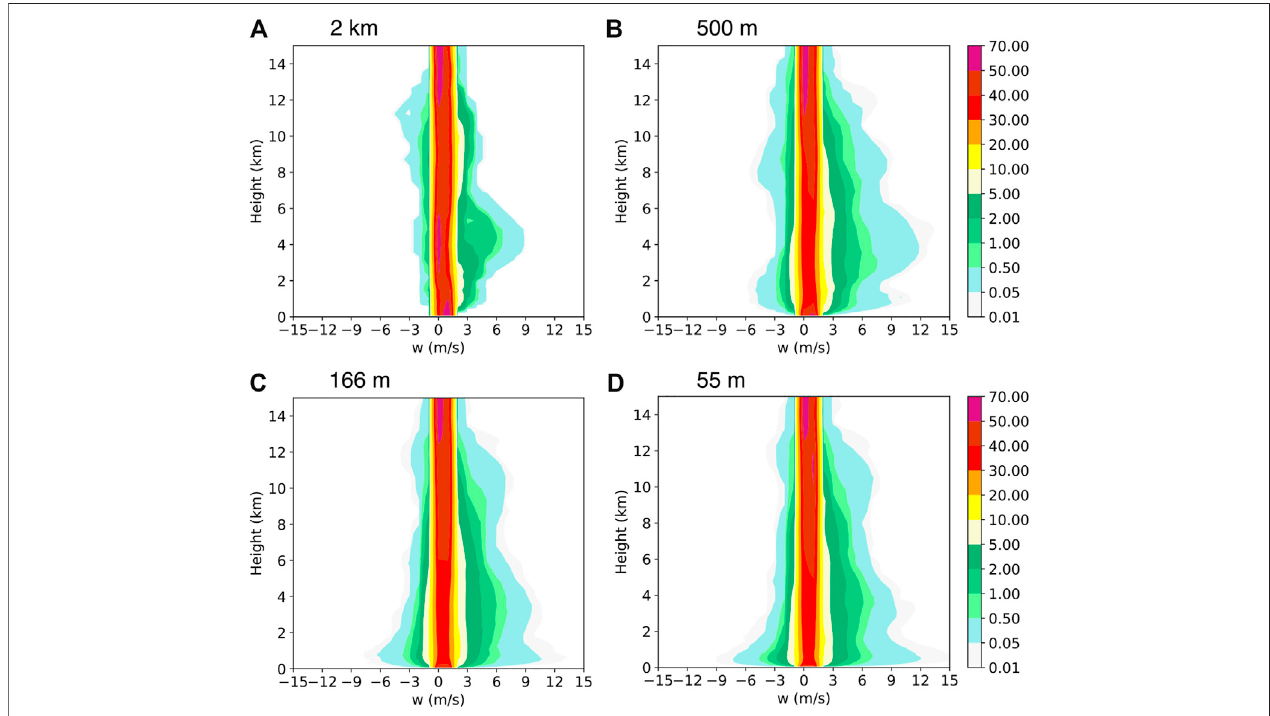
FIGURE5| CFADsofthesimulatedverticalvelocity(w;m s − 1 )intheradiusof41.25 kmfromthestormcenter(namelyinthed06domain)att (cid:2) 9 hofthesimulation from the grid spacings of (A) 2 km, (B) 500 m and (C) 166 m (D) 55 m, respectively.